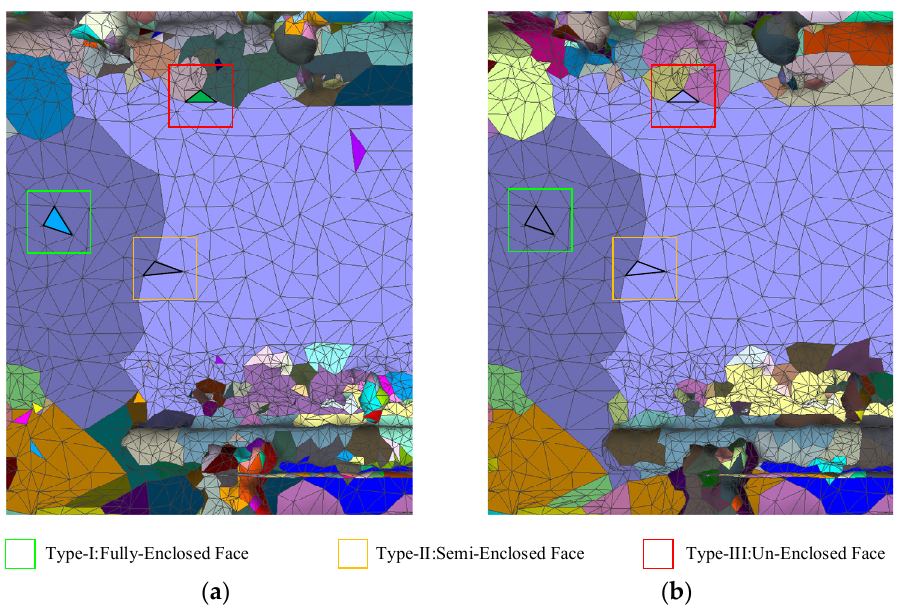
Figure 9. View label smoothing. ( a ) Unsmoothed label and ( b ) smoothed